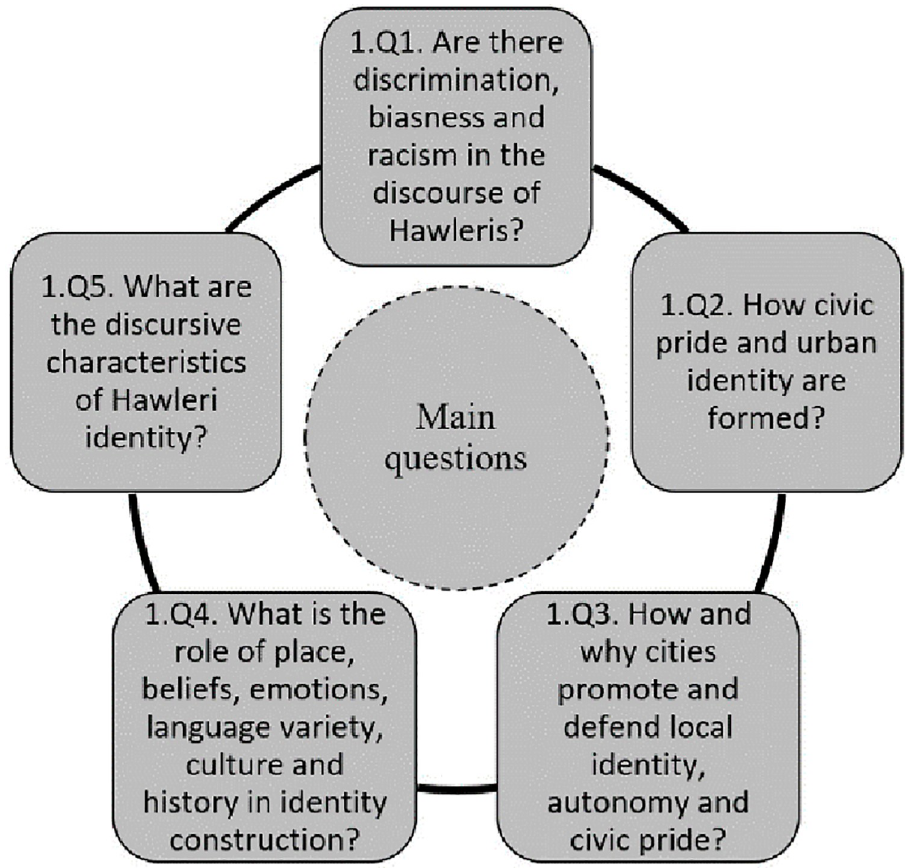
Fig 2. The main questions asked from the Hawleri